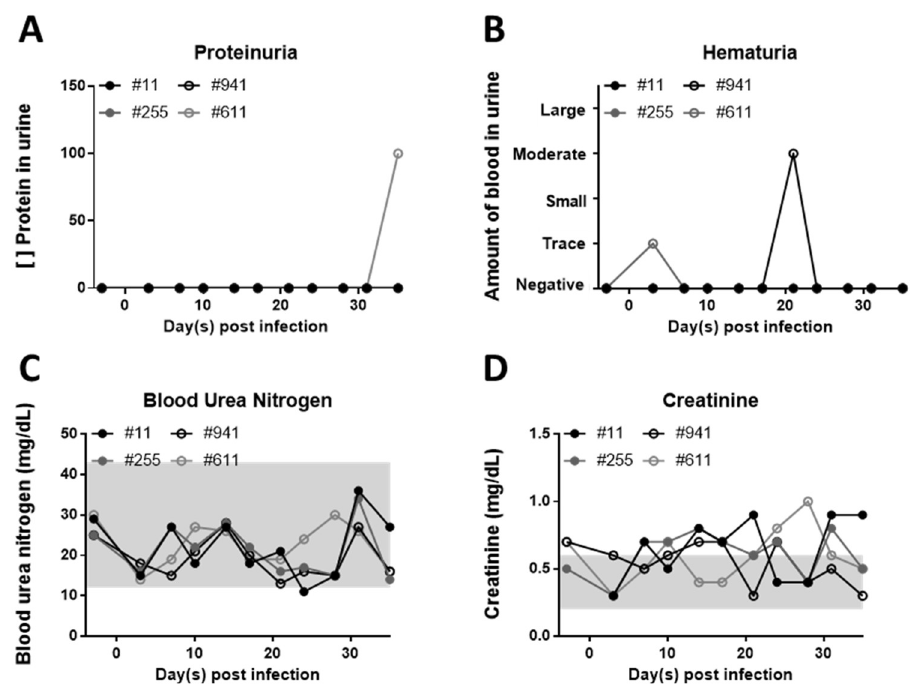
Fig 7. PUUV infected ferrets do not exhibit signs of kidney impairment. Ferrets were infected with 94,000 PFU PUUV Beaumont i.m. Blood and urine were collected twice weekly for analysis of kidney function by assaying proteinuria (A), hematuria (B), blood urea nitrogen (C), and creatinine (D) levels. Shaded gray areas represent the normal range [48].